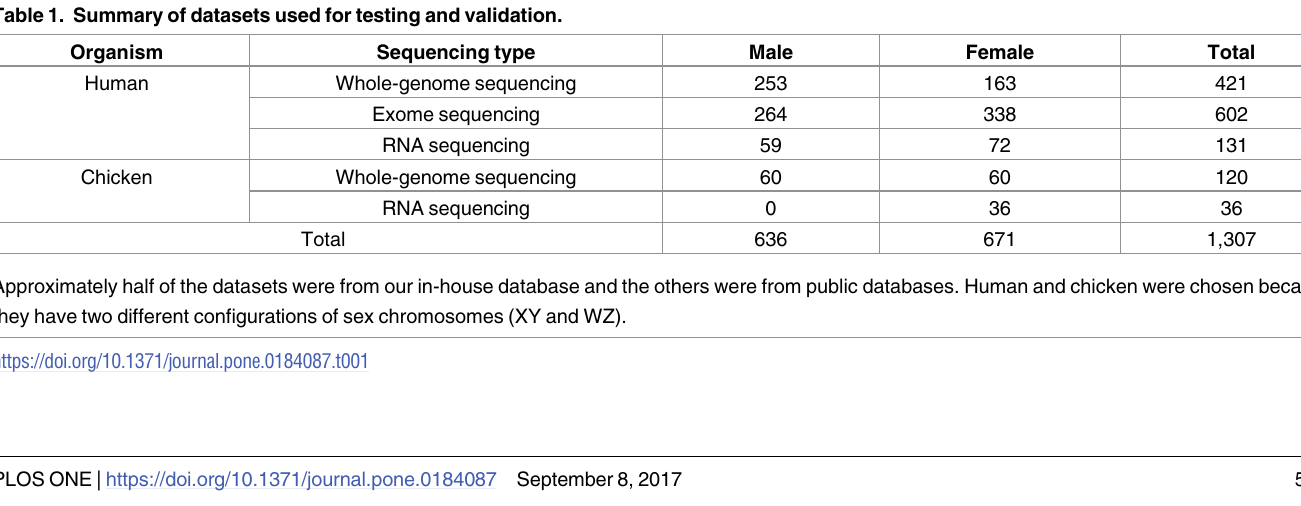
RNA sequencing datasets from our in-house database. A summary of these datasets including the sex of individuals sampled is shown in Table 1 and the accession numbers in public data-